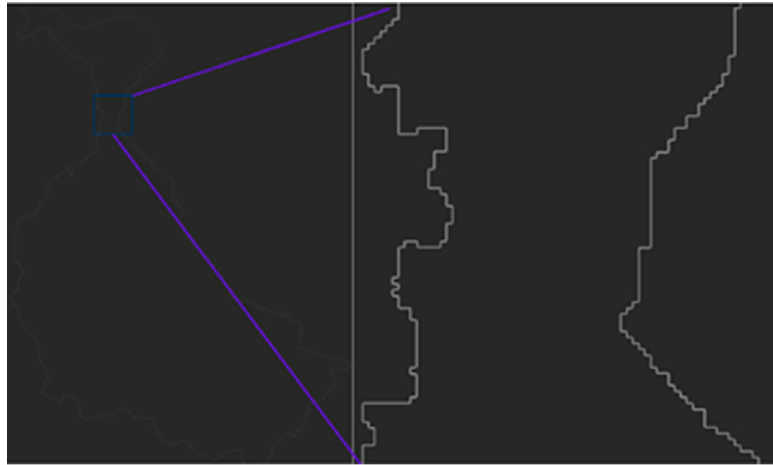
Figure 5. Result of Canny edge detection of Figure 4.